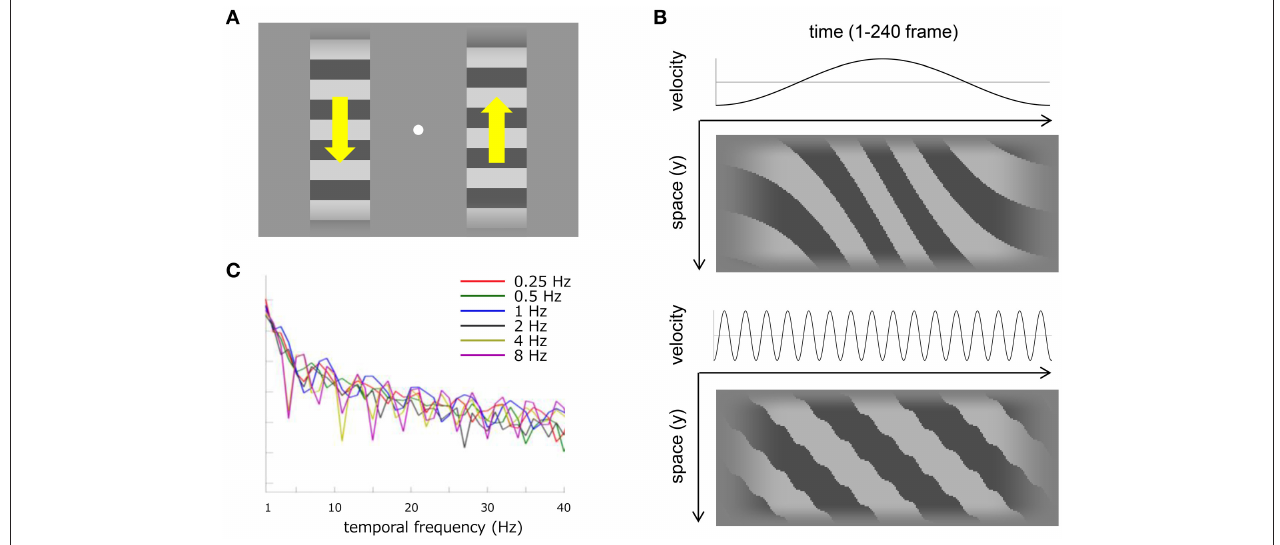
FIGURE 1 | Visual stimuli and stimulus analyses. (A) Schematic of the stimulus display used in Experiment 1 and 2. Horizontal square-wave gratings were displayed on each side of fixation (white dot). The spatial window was either square or elongated along the drifting direction (as illustrated here). The gratings drifted vertically but always in opposite directions to each other as denoted by yellow arrows. One of the gratings drifted at a uniform velocity of 10.7Hz and the other drifted with a sinusoidal modulation around 10.7Hz. The temporal frequency of the velocity modulation varied from 0.25 to 8Hz. (B) The top two panels illustrate 0.5Hz velocity modulation and the bottom two panels illustrate 8 Hz velocity modulation. Both upper panels show a temporal change of velocity along sinusoidal profile with a mean velocity of 22.7 degree/s. Both lower panels show a temporal change of luminance in the vertical dimension of the horizontal grating within the short spatial window. One horizontal pixel corresponds to one frame in the stimulus presentation. (C) Temporal-frequency spectrum of the velocity modulation at a sampling frequency of 120Hz. Each color corresponds to a different modulation